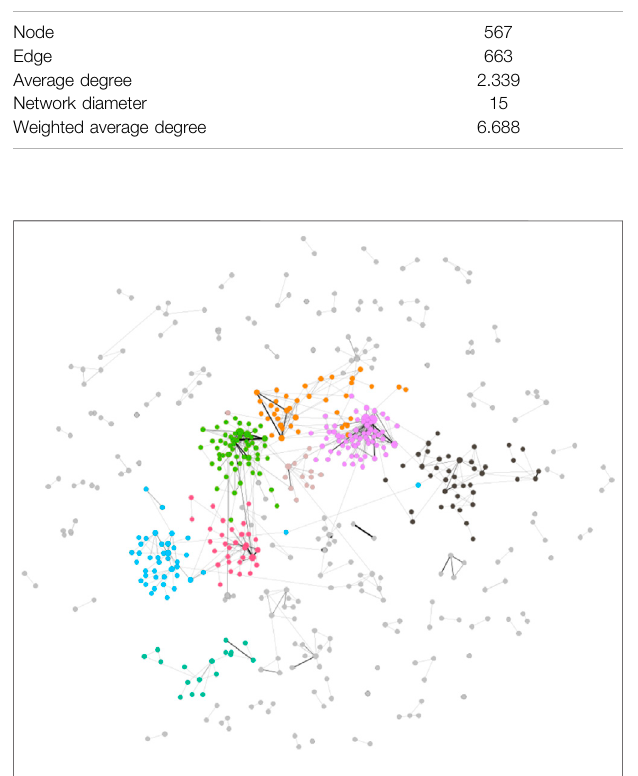
FIGURE 3 | Terrorist organization alliance network.